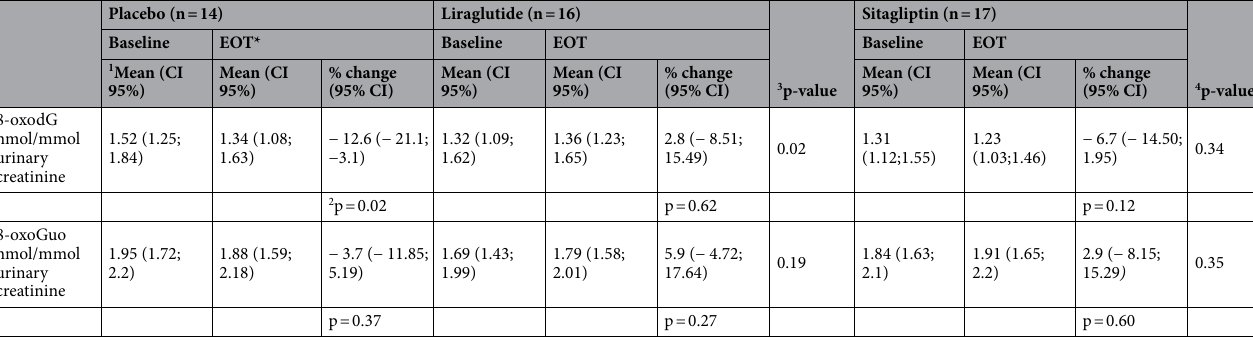
Table 3. Outcome measures for the SAFEGUARD trial. 1 Geometric mean with 95% confidence interval. 2 Paired-samples t-test. 3 Unpaired-samples t-test: change in the liraglutide treated group compared to placebo in urinary excretion of 8-oxodG and 8-oxoGuo. 4 Unpaired-samples t-test: change in the sitagliptin treated group compared to placebo in urinary excretion of 8-oxodG and 8-oxoGuo. *End-of-treatment.